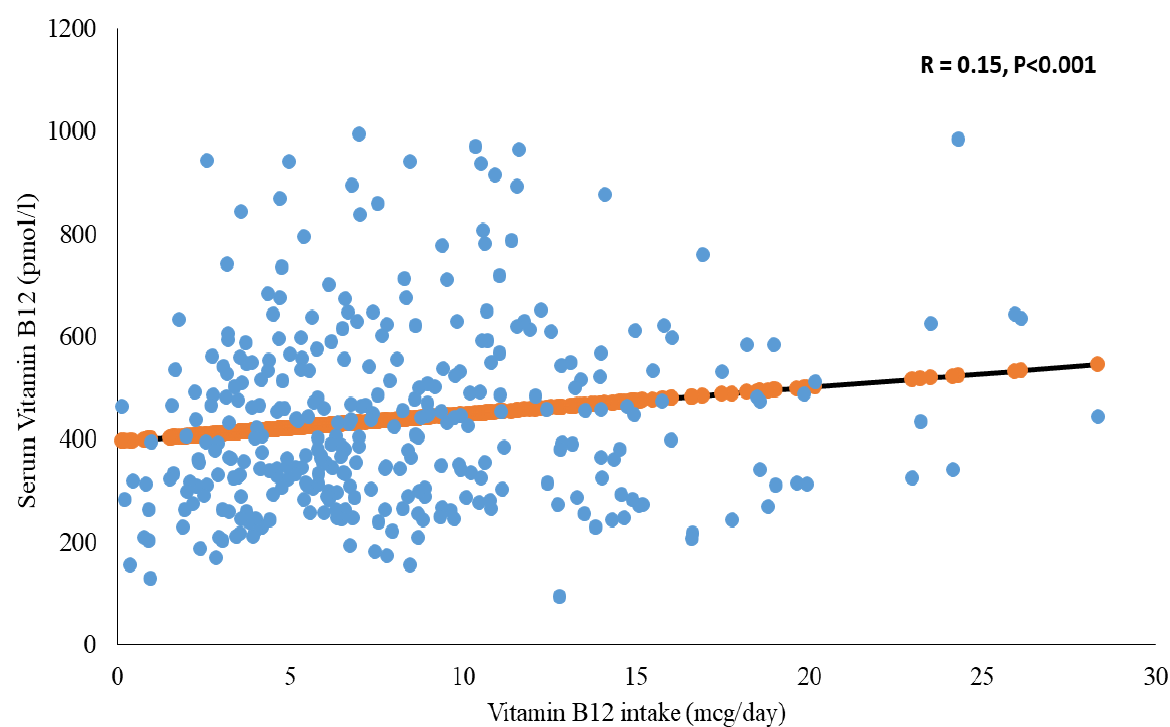
Figure 1. Correlation between vitamin B12 intake and vitamin B12 levels. 256